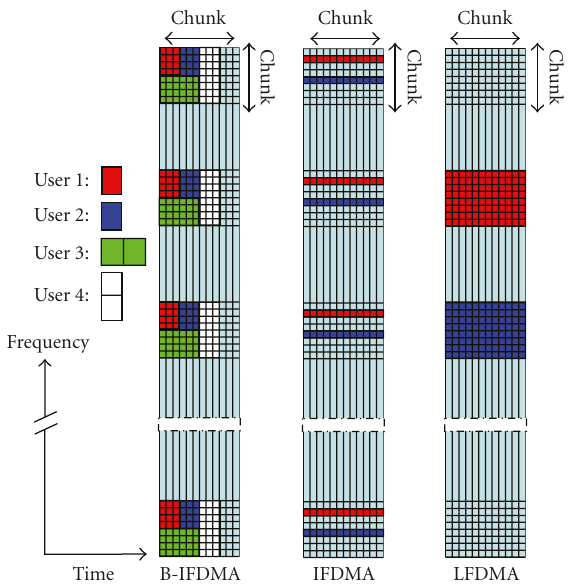
Figure 1: Illustration of B-IFDMA using M = 4 subcarriers and N t = 3 OFDM symbols per subcarrier block within a time- frequency resource denoted as chunk. SC-FDMA with localized mapping (LFDMA) and SC-FDMA with distributed mapping (IFDMA) are shown for comparison. In B-IFDMA, high rate users are allocated more blocks within the chunks in either the time or the frequency direction. (A similar illustration is included in